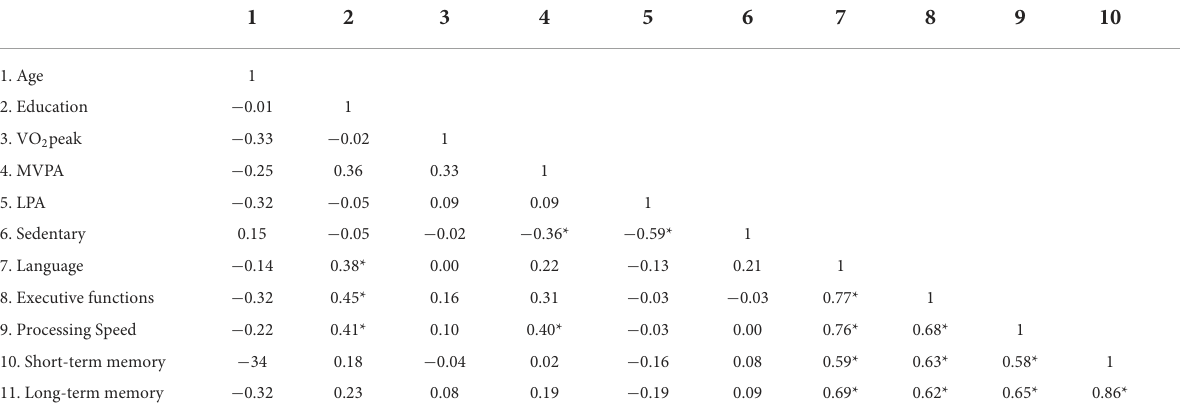
TABLE 2 Correlation analysis between physical activity measures and cognitive